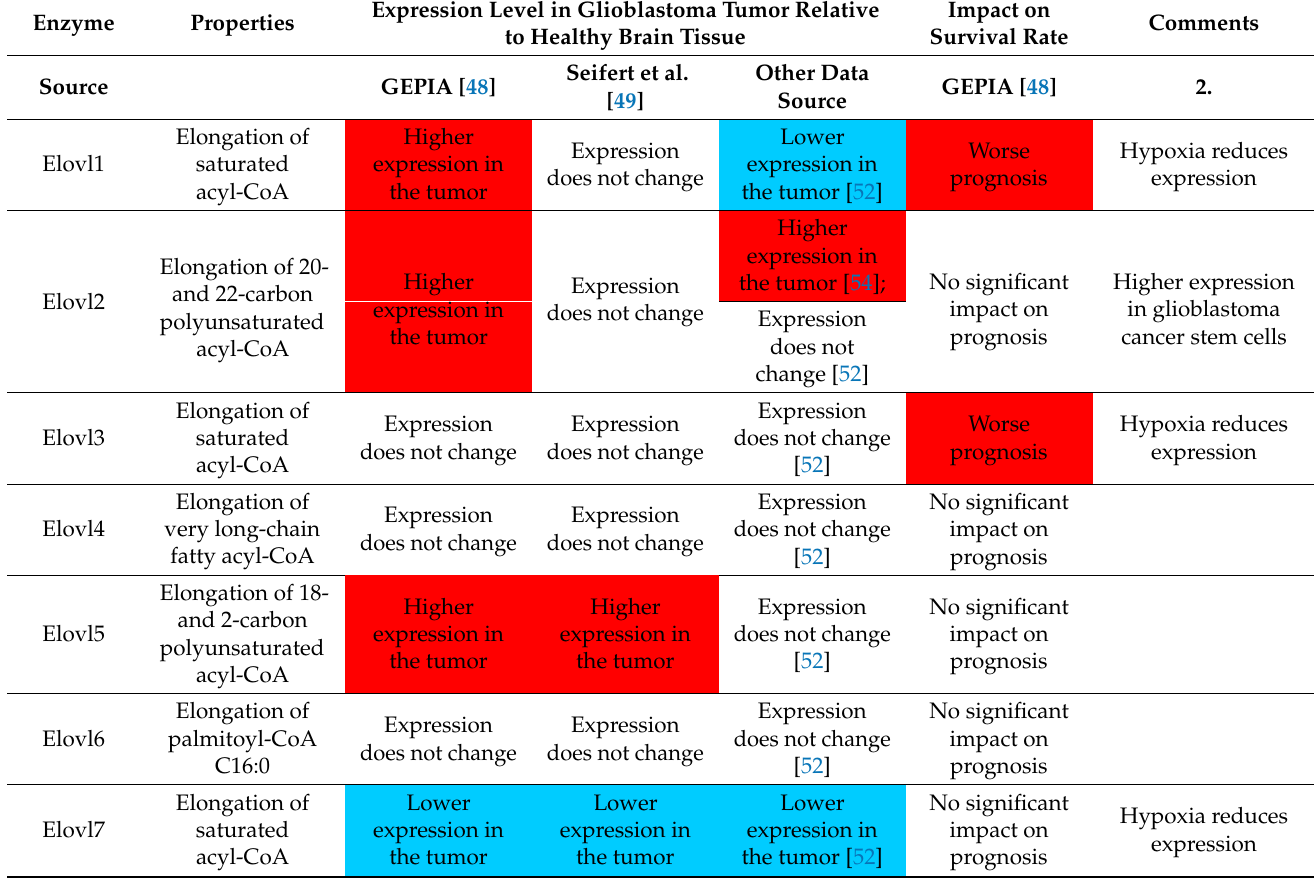
Table 2. Characteristics of elongases involved in the biosynthesis of fatty